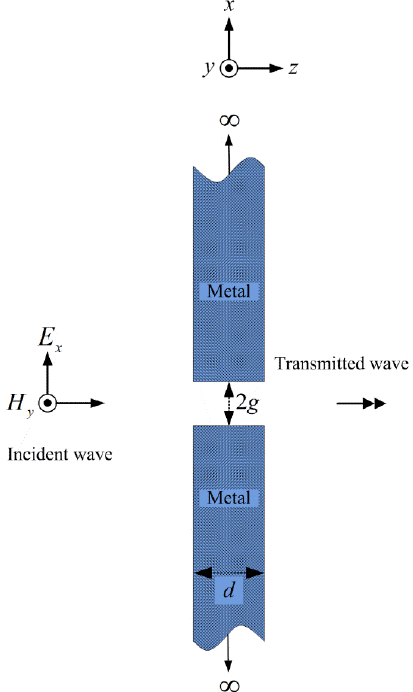
Figure 1. Geometry of a single metallic slit.